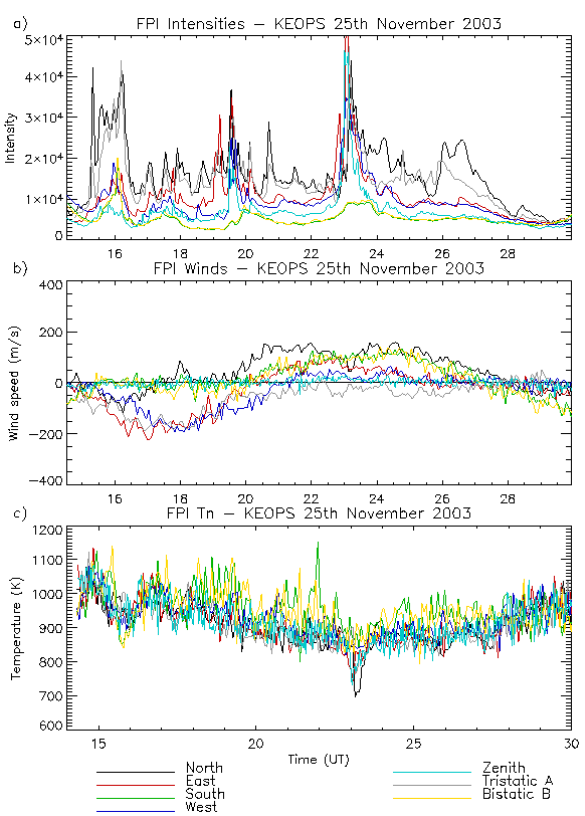
Fig. 1. 6300 ˚A intensities (a) , neutral winds (b) , and temperatures (c) for all the look directions from KEOPS on 25 November 2003.